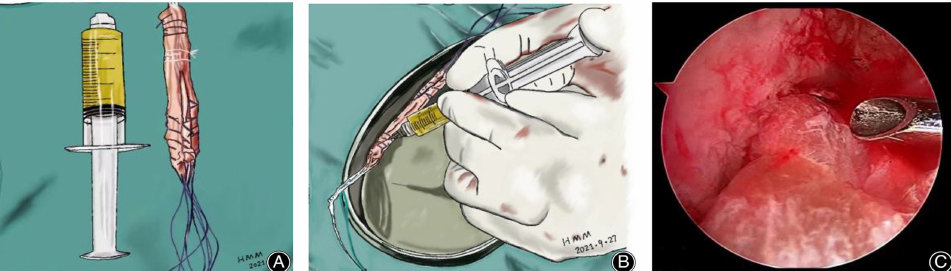
Figure 3. Preparation of PRP fluid and woven autologous hamstring tendon. Reprinted and adapted with permission from Ref. [54]. Copyright 2022 Orthop Surgery. ( A ) Image of the PRP fluid. ( B ) In the PRP group, 2.5 mL of PRP was injected into the tibial and femoral ends of the graft. ( C ) The graft was positioned properly after anterior cruciate ligament reconstruction. PRP, platelet-rich